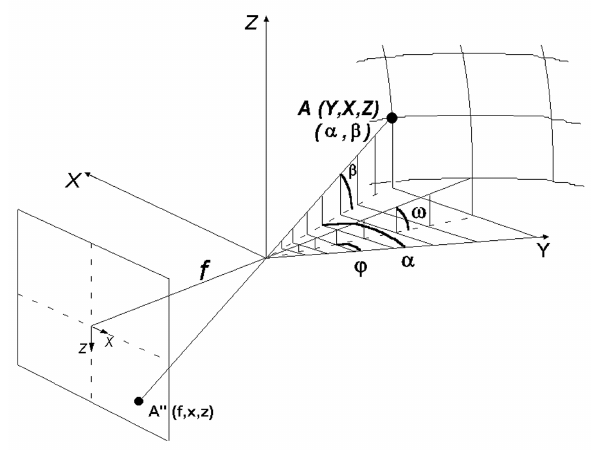
Fig. 3. Geometry of location of the observer (point L) and two points (A, B) in the NLC area.